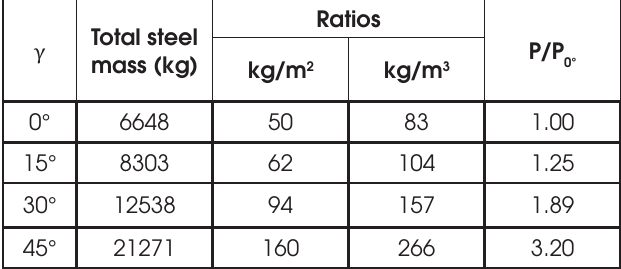
Total steel mass and ratios for flat bridges with lateral